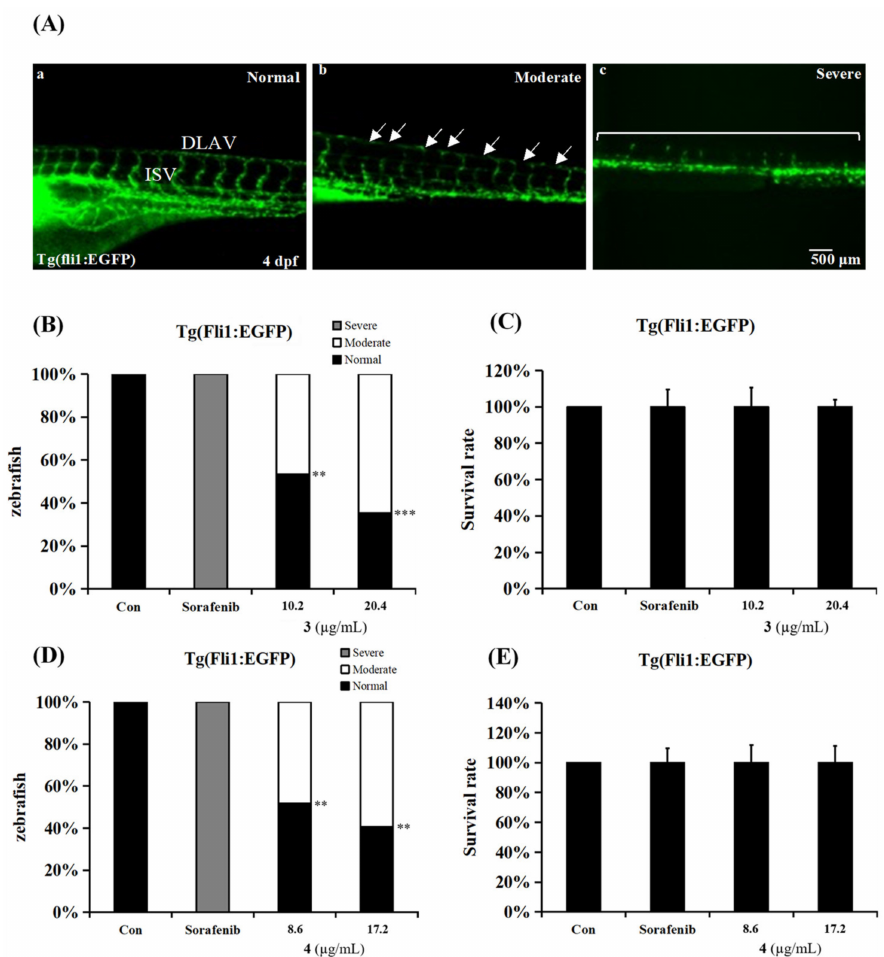
Figure 5. Penisterine C ( 3 ) and penisterine D ( 4 ) exert anti-angiogenic capacities in vivo. ( A ) Represen- tative images of the trunk vasculature in Tg (fli1:EGFP) zebrafish embryos incubated with compounds or sorafenib at 4 days post-fertilization (dpf). Arrows indicate impaired at intersegmental vessel (ISV) and dorsal longitudinal anastomic vessel (DLAV). ( B ) Quantitative analysis presents percentage of fish embryos incubated with 3 with defective vasculature. ** p < 0.01, and *** p < 0.001 compared with the control group. ( C ) Quantitative analysis presents percentage of survival rate of fish embryos incubated with 3 . ( D ) Quantitative analysis presents percentage of fish embryos incubated with 4 with defective vasculature. ** p < 0.01 compared with the control group. ( E ) Quantitative analysis presents percentage of survival rate of fish embryos incubated with 4 . The zebrafish treated with 1% DMSO was used as a negative control, and 10 µ g/mL sorafenib was used as a positive